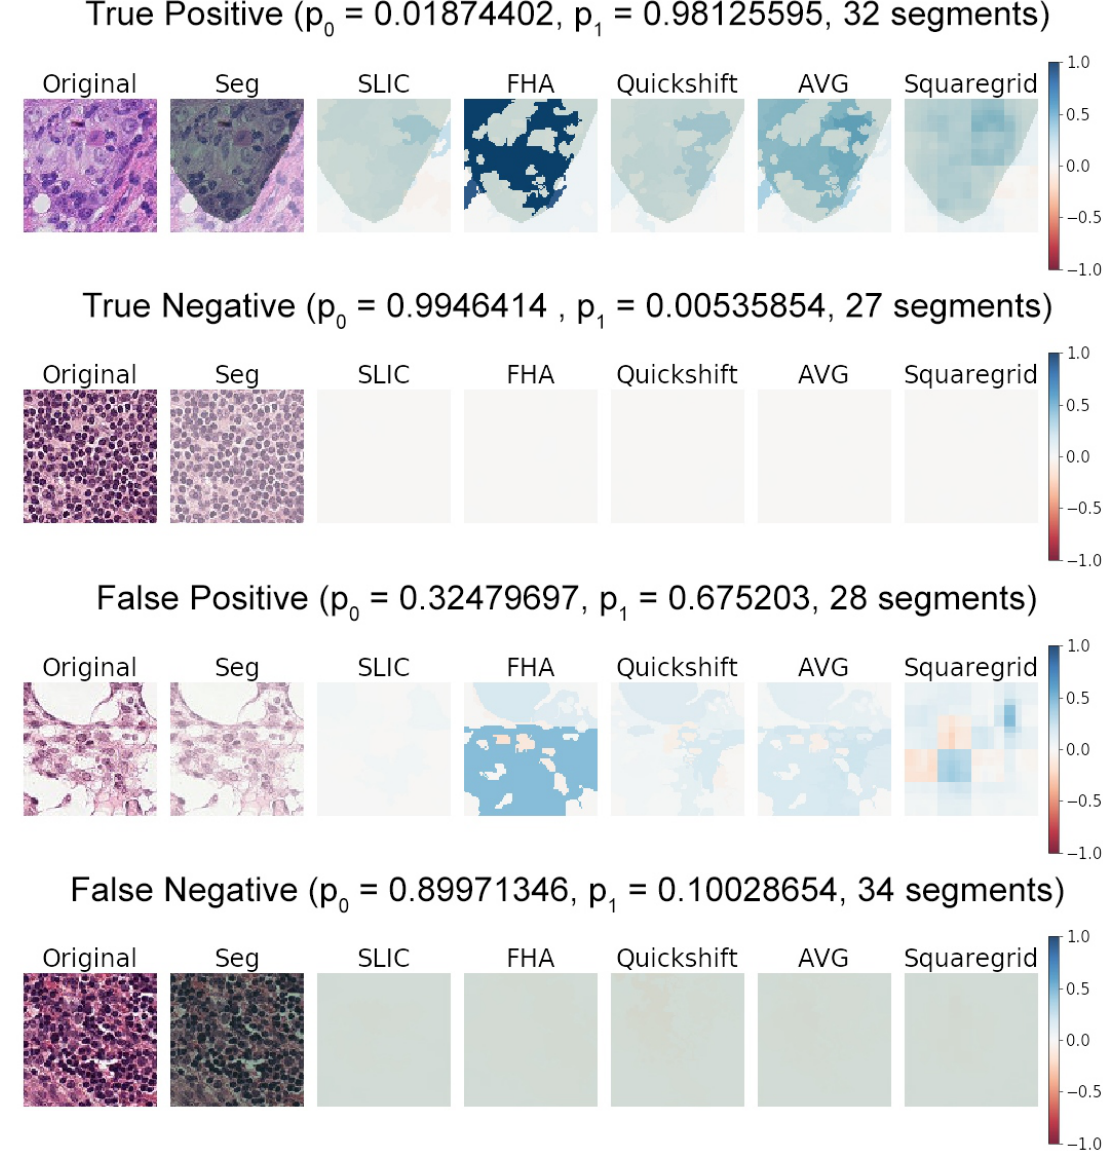
Figure 5. Examples of predictions by Model1, including a true positive, true negative, false positive, and false negative. The probabilities predicted for each class are also displayed as p 0 for Class 0 (no tumor tissue in the center 32 by 32 pixel square) and p 1 for Class 1 (tumor tissue present in the center). Explanations are plotted as weight heat maps for the respective predicted classes, with blue indicating positive weights (in favor of the prediction) and red indicating negative weights (against the prediction). Segmentation (Seg) (green transparent overlays) represent the medical annotation for a given image. AVG represents the arithmetic average of the SLIC, FHA, and quickshift heat